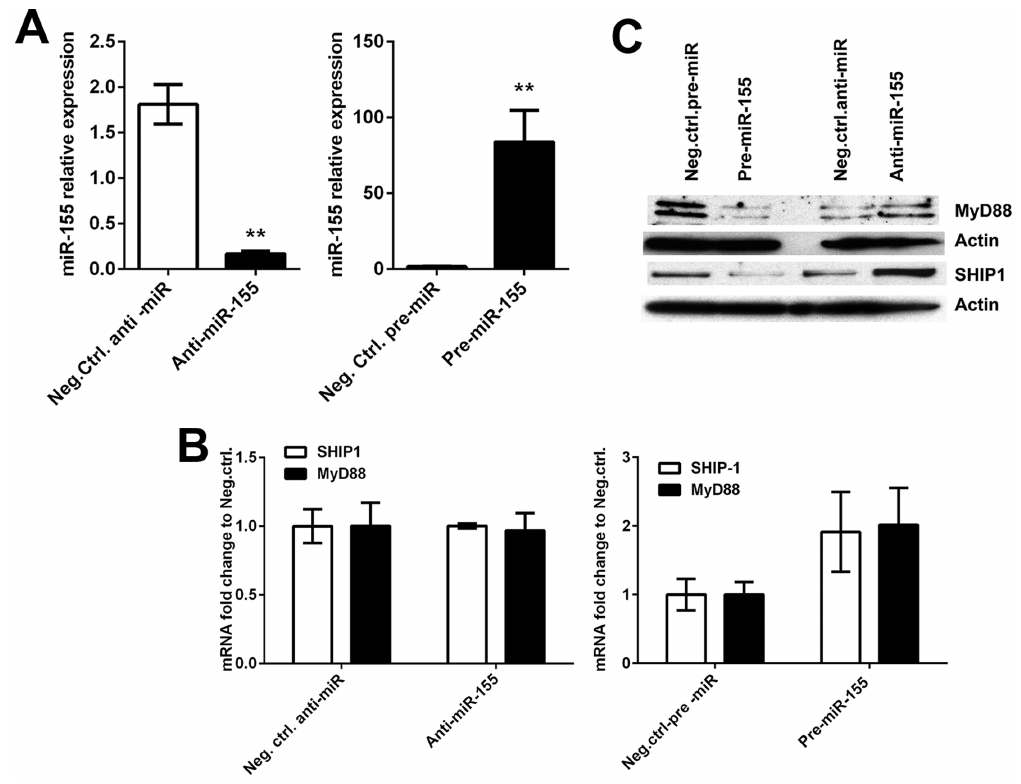
Figure 4. Direct manipulation of miR-155 levels alters MyD88 and SHIP-1 protein abundance, but not their mRNAs. MDMs were transfected with negative control and miR-155 mimic (pre-miR), or with negative control and miR-155 inhibitor (anti-miR) as indicated. A . miR-155 expression was analyzed using a Taqman microRNA assay and was normalized to RNU48. Data are mean 6 SEM (n=3). ** P , 0.01 vs. the negative control. B . SHIP-1 and MyD88 mRNAs were quantified 48 h after transfection using qRT-PCR with GAPDH as the internal control. Data are mean 6 SEM (n=3). C . SHIP-1 and MyD88 proteins were detected in MDM lysates by immunoblotting. b -actin was used as the loading control. Data shown are from one experiment representative of